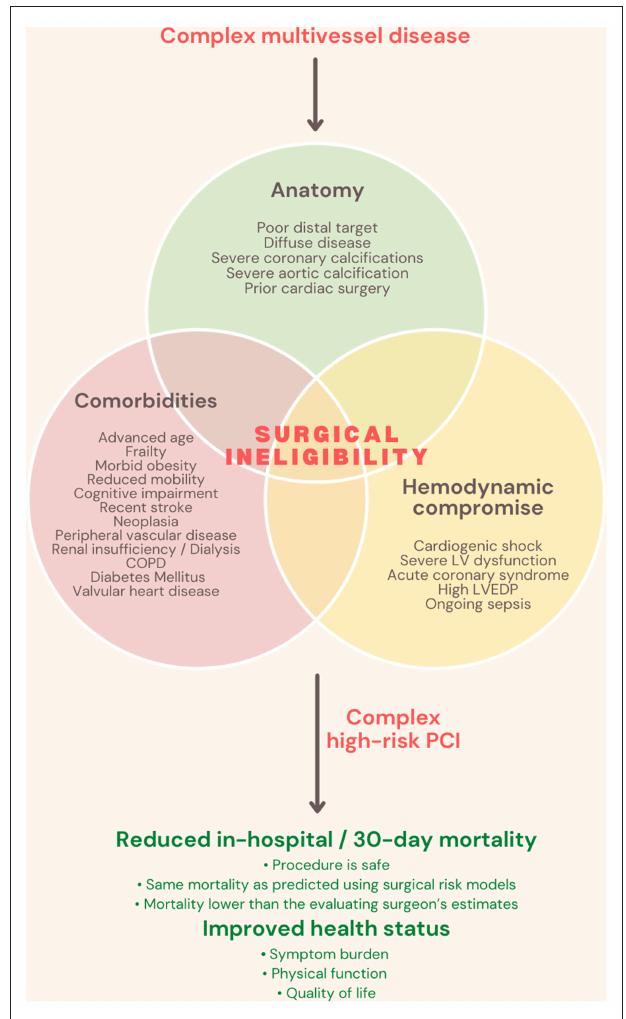
FIGURE 1 | Complex high-risk indicated procedures definition and benefits. COPD, Chronic obstructive pulmonary disease; LV, left ventricle; LVEDP, left ventricular end-diastolic pressure; PCI, Percutaneous coronary